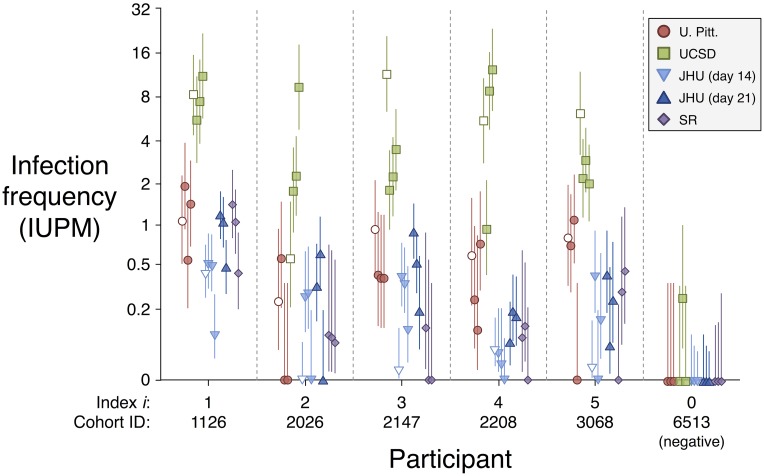
Infection frequency and 95% CI estimated separately for each aliquot by maximum likelihood (i.e., not using the mixed effects statistical model, see Methods: “Analyzing aliquots separately”).Cryopreserved aliquots are indicated by shaded symbols, fresh aliquots by open symbols. “Index i” is used in model output, and “Cohort ID” represents the identifier used in the SCOPE/OPTIONS cohort.